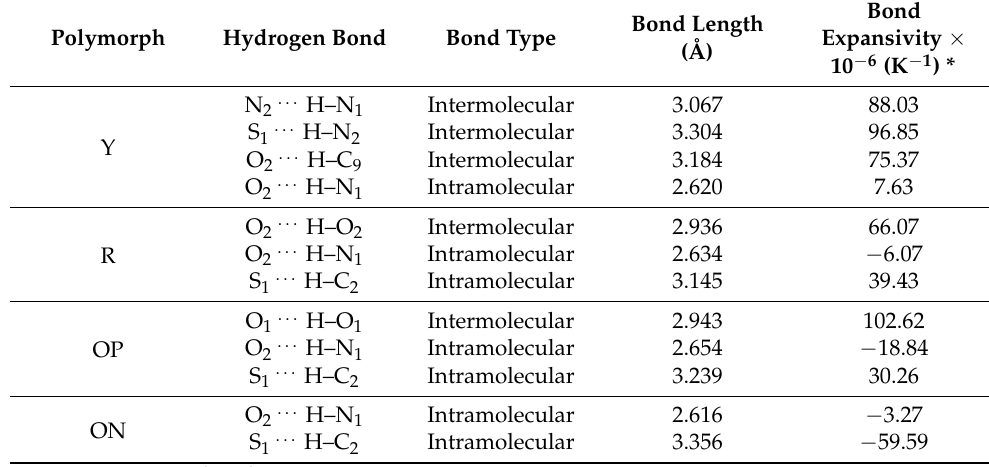
Table 2. Expansivity hierarchy of hydrogen bonds in ROY polymorphs at 123 K.